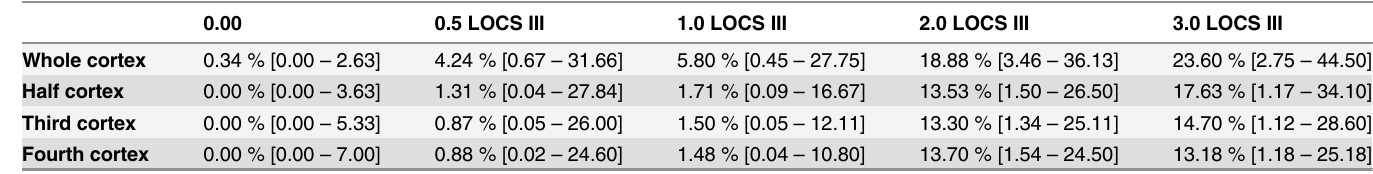
white points represent the eyes analysed, which positions in the graph were fixed by their corre- sponding LOCS grading and the percentage of opaque cortex. Furthermore, the tendency line Table 3. Median and Interval of the Cortex Opacity, Including the Clear one (0.00), as a Function of the Mask